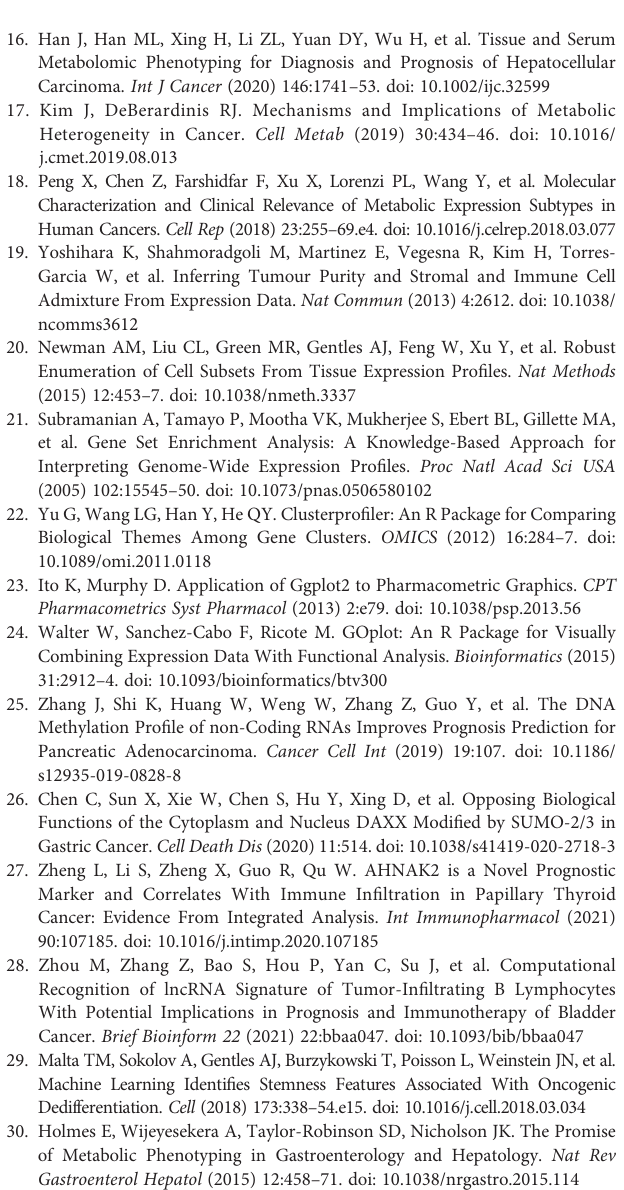
Supplementary Figure 2 | Different tumor immunoin fi ltration between Metabolism_HandMetabolism_L. (A) thetwoclustersshowedsigni fi cantlydifferent Stromal Score in LIRI − JP (Kruskal – Wallis test), while no signi fi cantly different Stromal Score in TCGA (Kruskal – Wallis test); (B) Immune Score was higher in Metabolism_H (Kruskal – Wallis test) both in TCGA and LIRI − JP; (C) Tumor Purity was higher in Metabolism_L (Kruskal – Wallis test) both in TCGA and LIRI − JP; (D) ESTIMATE Score was higher in Metabolism_H (Kruskal – Wallis test) both in TCGA and LIRI − JP. *P < 0.05, **P < 0.01, ***P < 0.001. Supplementary Figure 3 | The immune checkpoints related gene expression and the cancer stemness analyses. (A) PD-L1, CTLA-4 and TIM-3 expressed more in Metabolism_H; (B) mRNA expression-based stemness index (mRNAsi) was higher in the Metabolism_H. ***P < 0.001. Supplementary Figure 4 | The expression of 3 genes in cancer and matched normaltissues. (A) Representativeimageofimmunohistochemistrystainingand (B – D) immunohistochemical staining scores. (× 200, Scale bar = 100 µm). Data are presented as the means ± SD. ns, not signi fi